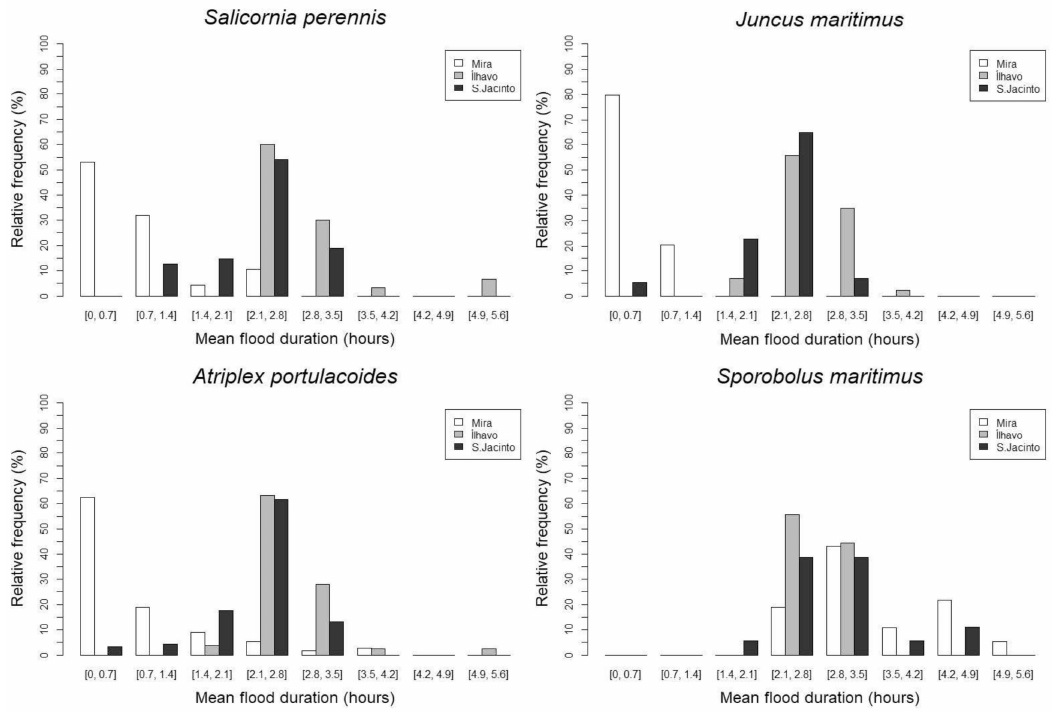
Figure A4. Mean flood duration (FD (hours)). Relative frequency distribution of the main species regarding the mean flood duration for each of the studied marshes.